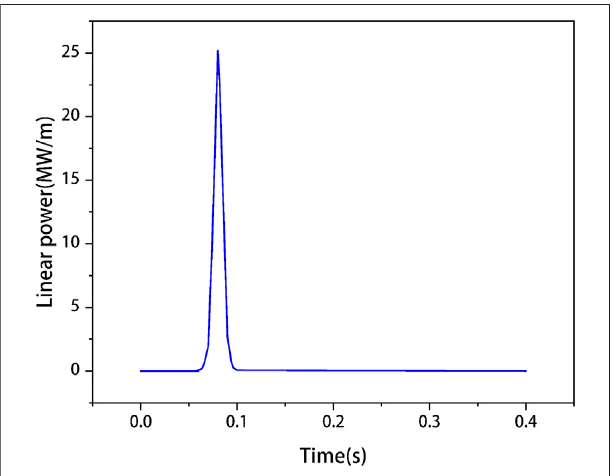
FIGURE5| CladdingoutersurfacehoopstrainevolutionsoftheUO 2 fuel with Zircaloy cladding calculated by the FRAPTRAN and CAMPUS codes under the LOCA condition.